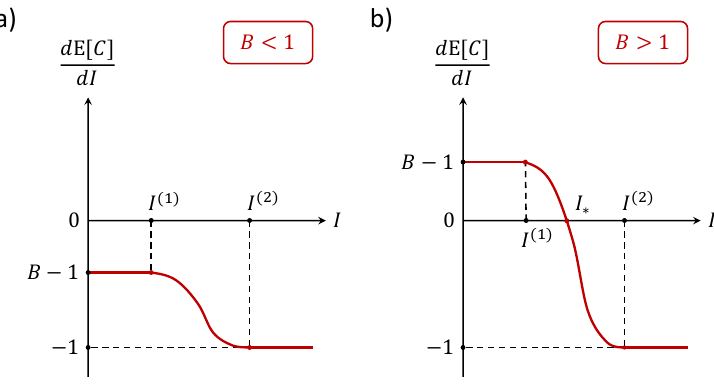
Figure 3. A derivative of expected discounted consumption over adaptation investment dE [ C ] / dI as a function of I . ( a ) A non-dimensional model indicator B given by Equation (12) obeys an inequality B < 1. ( b ) Same as ( a ), but for the opposite case B >